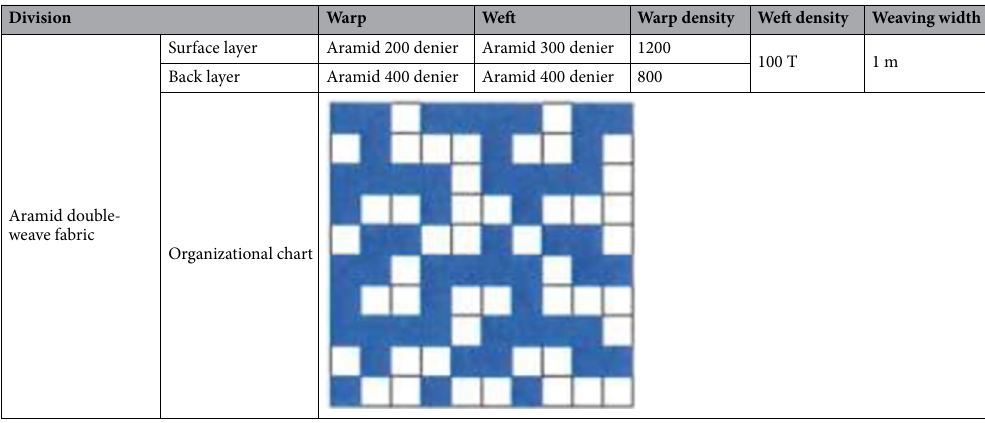
Table 1. Design table for aramid double-weave